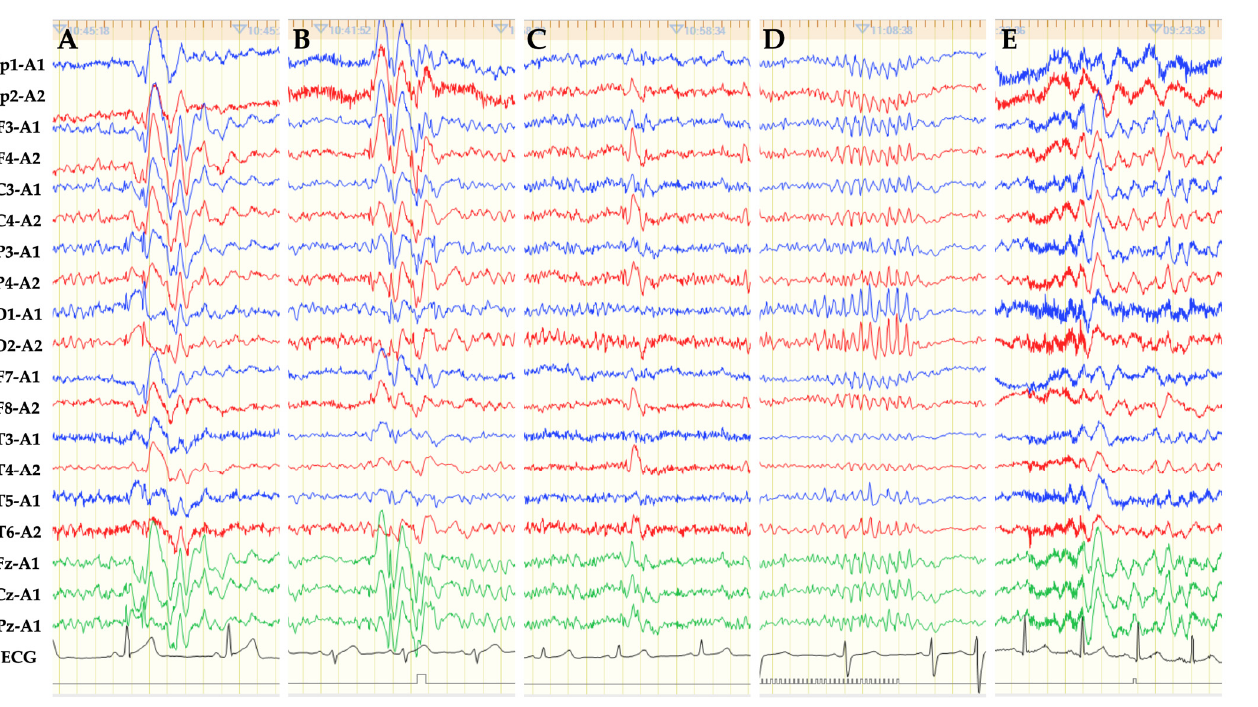
Figure 2 . EEG of referential derivation using the 10–20 international system shows various forms of IEDs. ( A ) GSWs are characterized by bilateral, synchronous SWs found in all regions. ( B ) Bilateral SWs are defined as bilateral, synchronous SW not found in all regions. This representative EEG shows bilateral SWs in the areas except the temporal region. ( C ) Lateralized SWs (focal) show SW only on the left or right side. ( D ) Spike or sharp burst refers to consecutive spike or sharp waves. ( E ) Slow waves without preceding spike or sharp waves were excluded from IEDs in this study. Sensitivity = 10 μ V/mm; time constant = 0.3 s; high frequency filter = 60 Hz; paper speed = 3 cm/s.